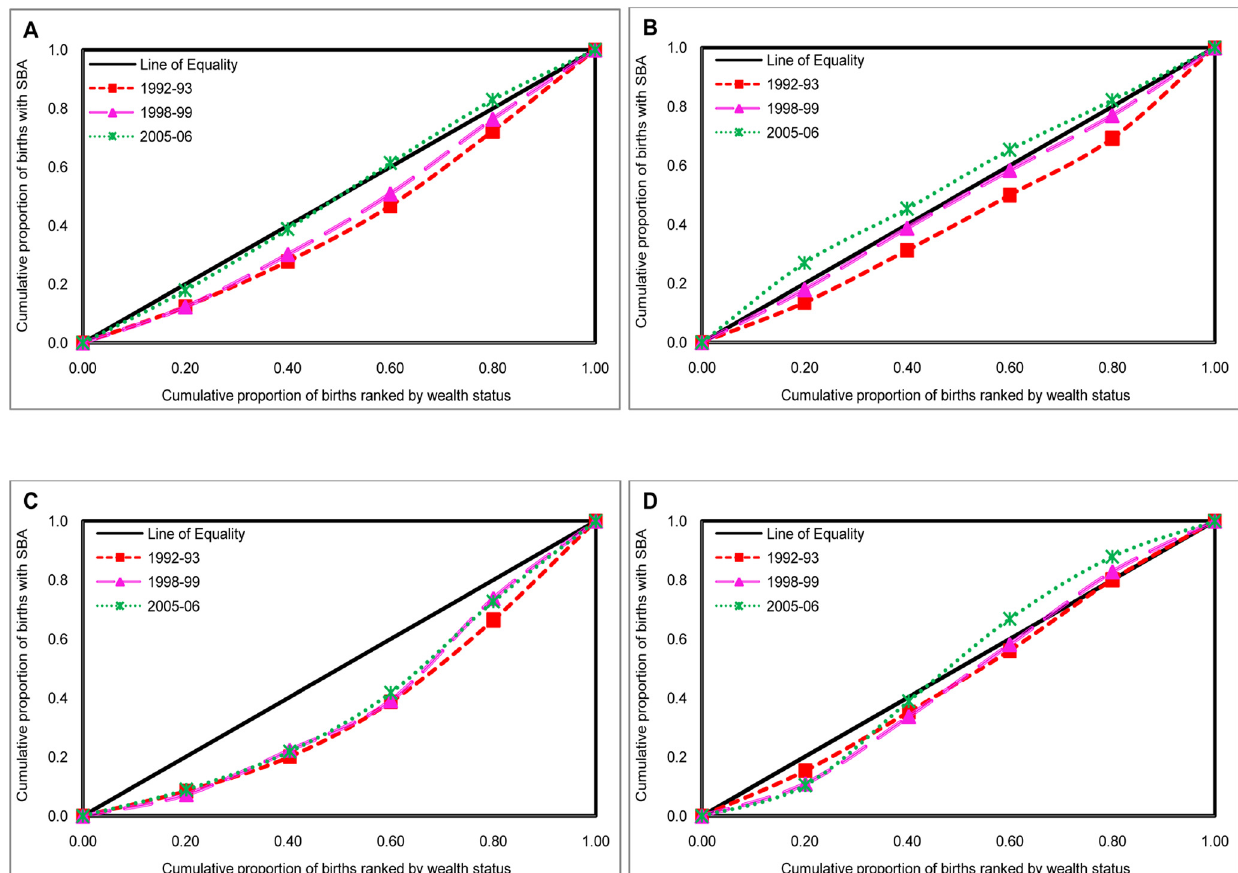
Figure 3. Concentration curves showing inequalities in skilled birth attendance (SBA) by economic status of population across states, India, 1992–2006. A [INDIA] . B [UTTAR PRADESH] . C [MAHARASHTRA] . D [TAMILNADU] . X axis=Cumulative proportion of births ranked by wealth status. Y axis=Cumulative proportion of births with prenatal care (PNC). Red square=Concentration curve for 1992–93. Pink triangle=Concentration curve for 1998–99. Green cross=Concentration curve for 2005–06.